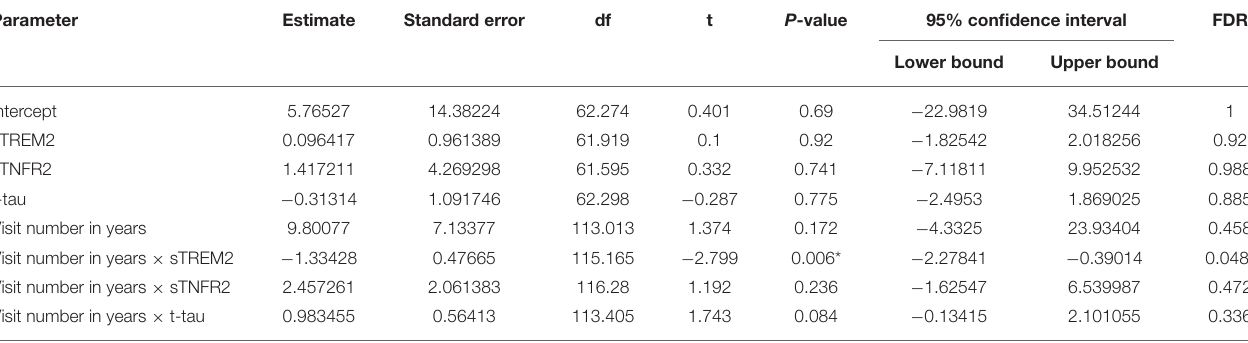
TABLE 7 | Key results of the linear mixed-effects regression model with CDR-SB as the dependent variable among participants with A + T + AD dementia from the Alzheimer’s Disease Neuroimaging Initiative (ADNI) cohort (Model 3). Parameter